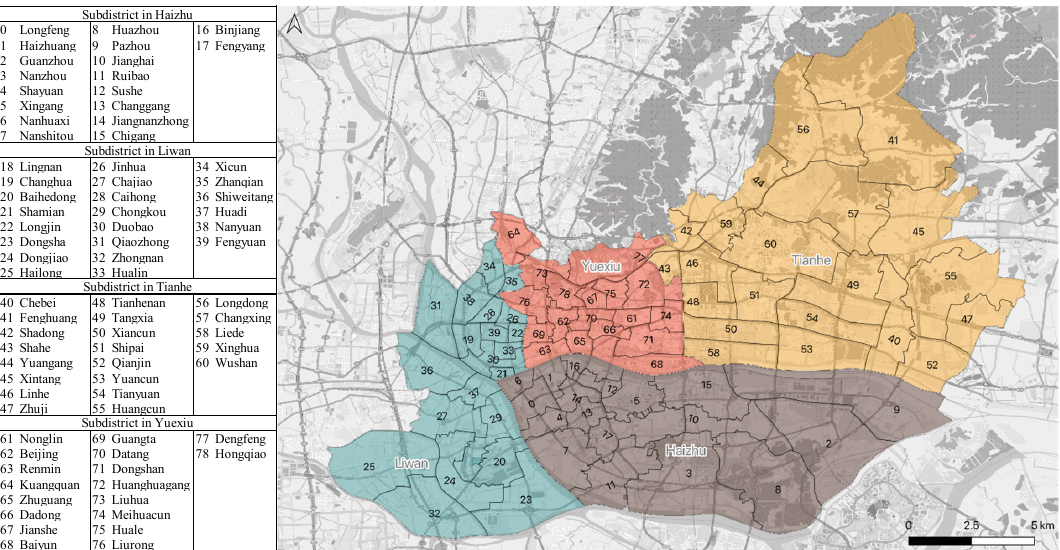
Figure 7. Study area in Guangzhou. The four districts are highlighted in different colors, the serial numbers of the seventy-nine subdistricts are labeled, and their subordination and correspondence are shown on the left.